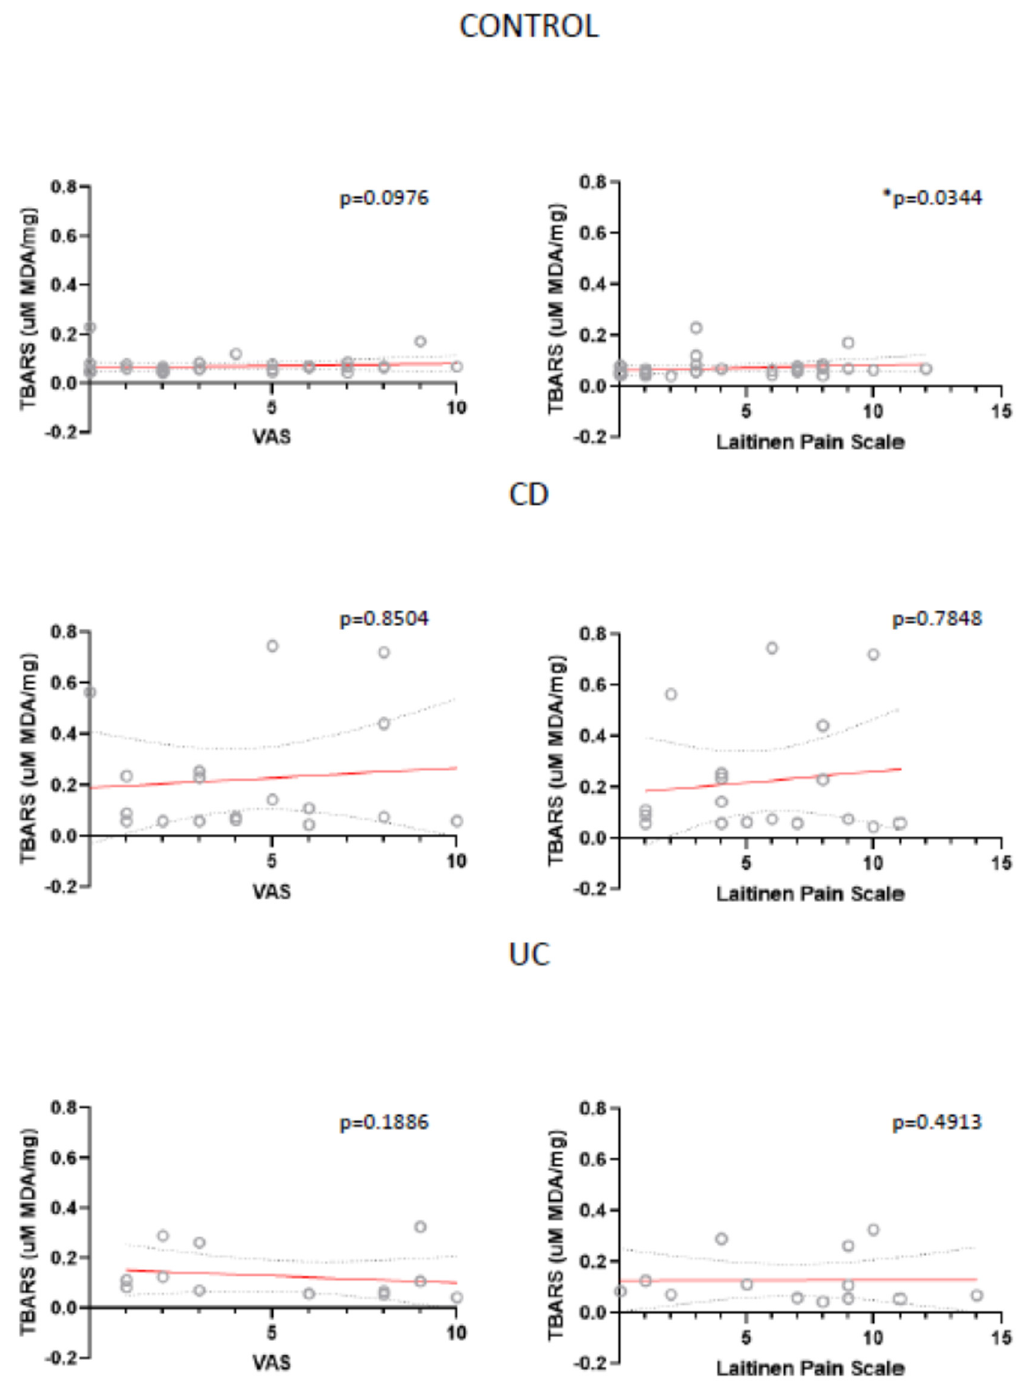
Figure 8. Correlation between the mean values of visual analog scale (VAS) for quantification of disease-related pain, the values of modified Laitinen Pain Scale and Thiobarbituric Acid Reactive Substances (TBARS) presented as concentration of malondialdehyde (uM MDA/mg sample) in controls, CD and UC patients.